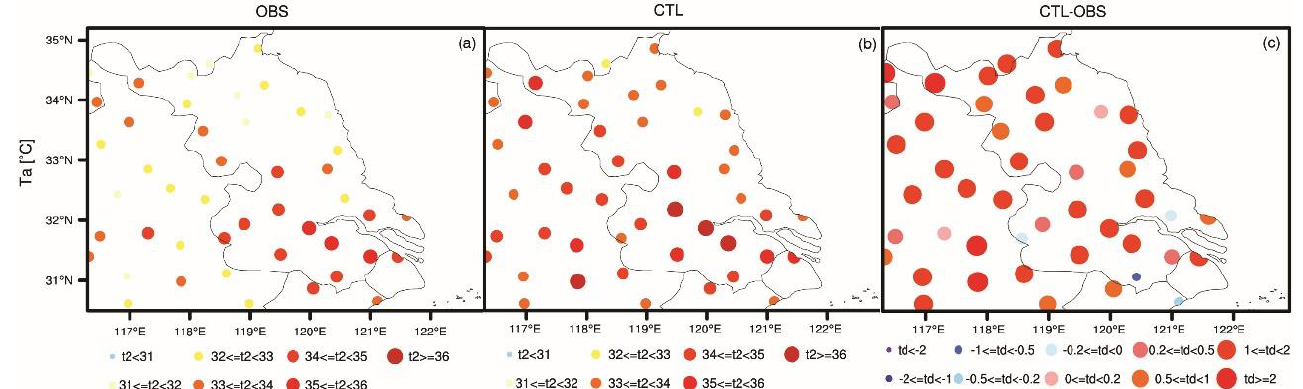
7 of 17 Figure 3. Spatial-distribution characteristics and relative differences over research period in EC. ( a1 , a2 , a3 ) Albedo and relative difference between WRF and MODIS data; ( b1 , b2 , b3 ) LAI and relative difference between WRF and MODIS data; ( c1 , c2 , c3 ) 10 cm soil water and relative difference between WRF and CLDAS data (unit: m 3 m −3 ) and ( d1 , d2 , d3 ) 30 cm soil water and relative difference between WRF and CLDAS data (unit: m 3 m −3 ). 3.2. Model Validation To validate the performance of the developed modeling system, the simulation re- sults of the WRF_CTL were compared with the observed Ta from the AWS network. Fig- ures 4a and 5a show the spatial distribution of the observed Ta during the hot weather in EC, particularly mean Ta and Tamax. The large-area higher-observation Ta appeared south of Jiangsu province and the Shanghai, and the highest 5 day mean observation Ta